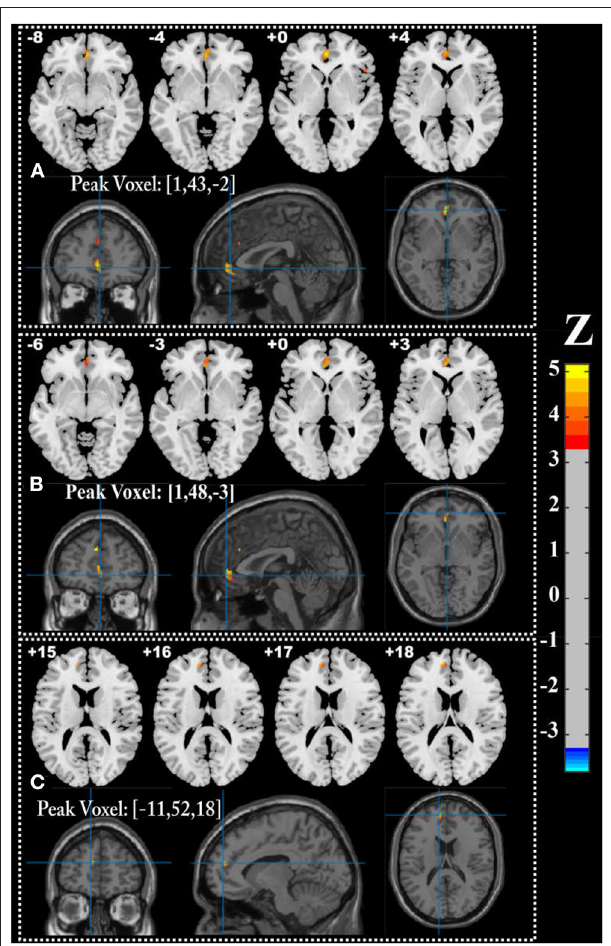
FIGURE 3 | Brain regions showing significantly decreased GMV in (A) CSVD-c group and (B) CSVD-n group (ANOVA and LSD post-hoc test with GRF correction, voxel level p < 0.001, cluster level p < 0.05), and (C) decreased WMV in CSVD-n group compared with control